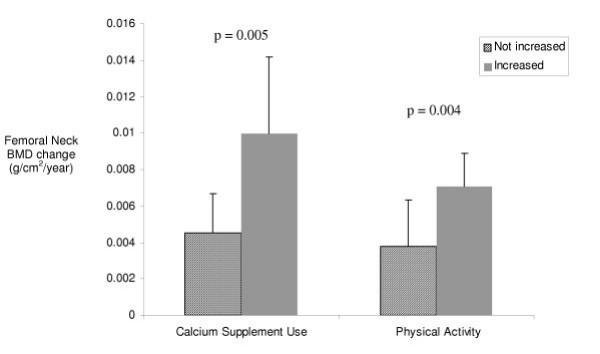
Mean absolute change in femoral neck BMD per year for women who did or did not increase calcium supplement use or physical activity. Data is presented as mean and upper 95th CI. P-values are for differences between women who changed and who did not change each behavior.